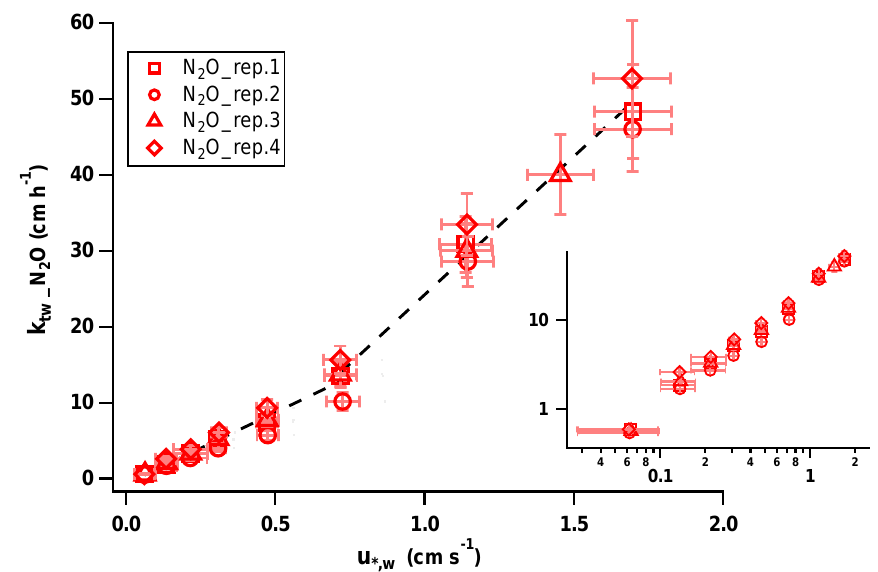
Figure 7. Total transfer velocity of N 2 O of four clean case repetitions plotted against u ∗ , w . Squares correspond to repetition 1, circles to repetition 2, triangles to repetition 3 and diamonds to repetition 4. Vertical bars in light red give the individual transfer velocity uncertainty (see Sect. 3.2.3) and the horizontal bars the uncertainty of the u ∗ , w measurements.